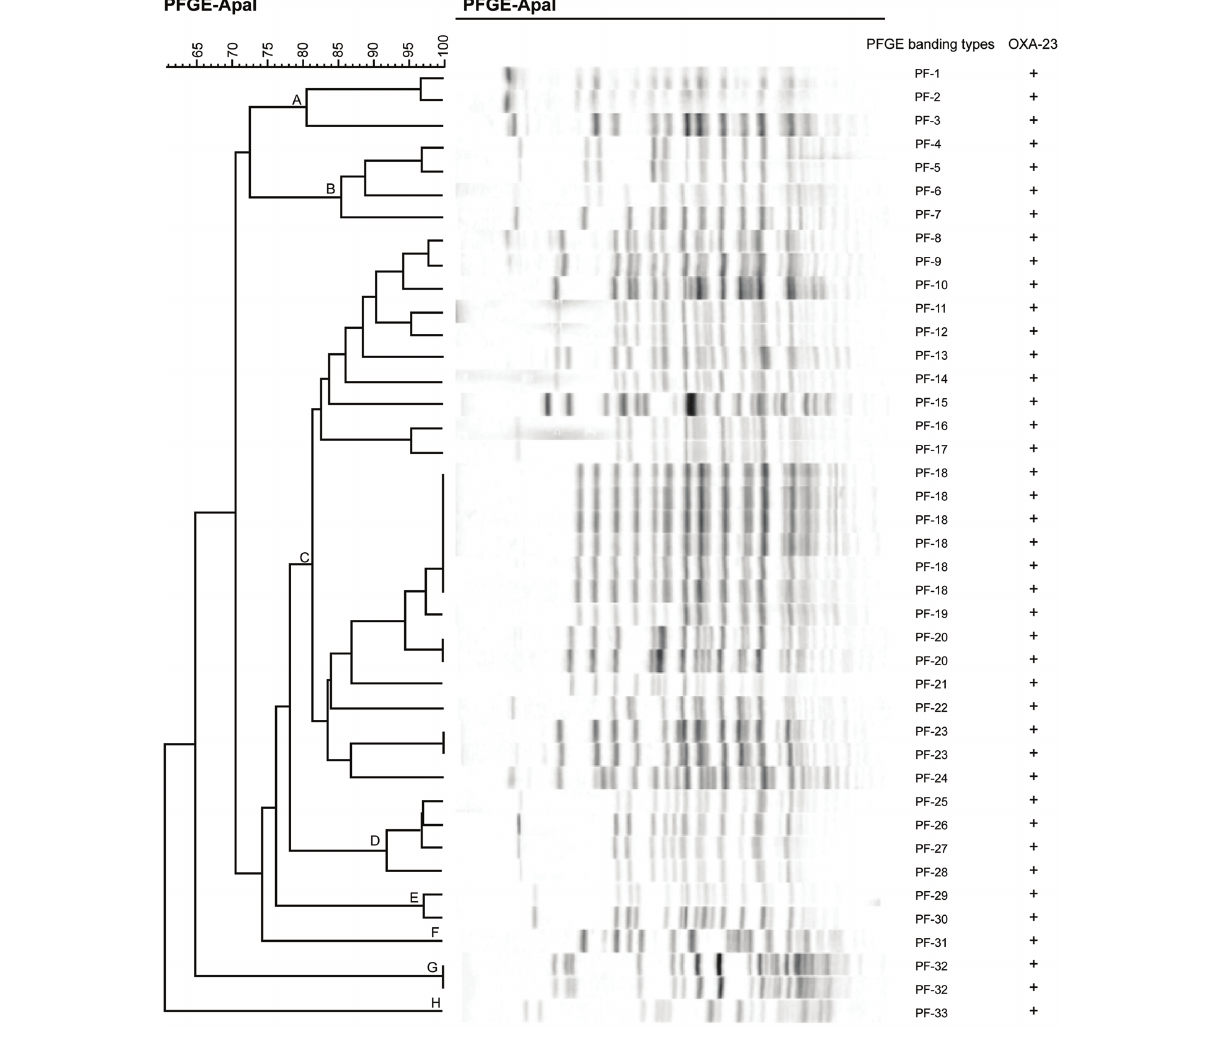
FIGURE 5 | Pulsed-field gel electrophoresis (PFGE) of Apa I-digested DNA from 41 A. baumannii isolates. The dendrogram shown was generated via the unweighted pair-group method using arithmetic averages approach, based on Dice similarity coefficients that were determined using BioNumerics software,